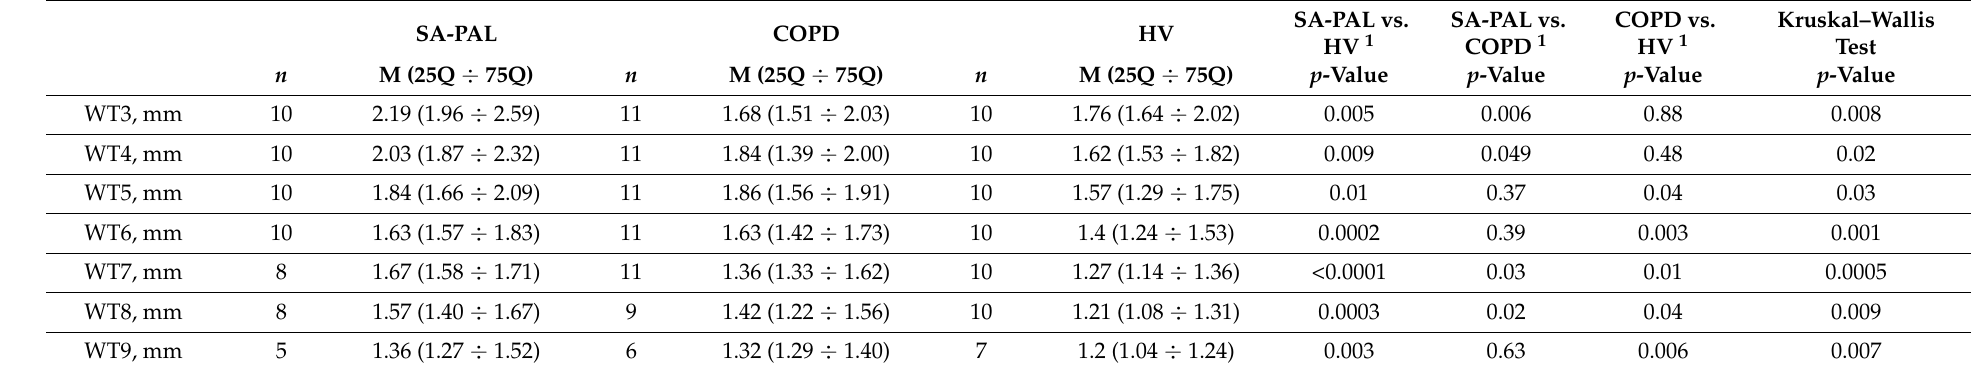
Table 2. Wall thickness.